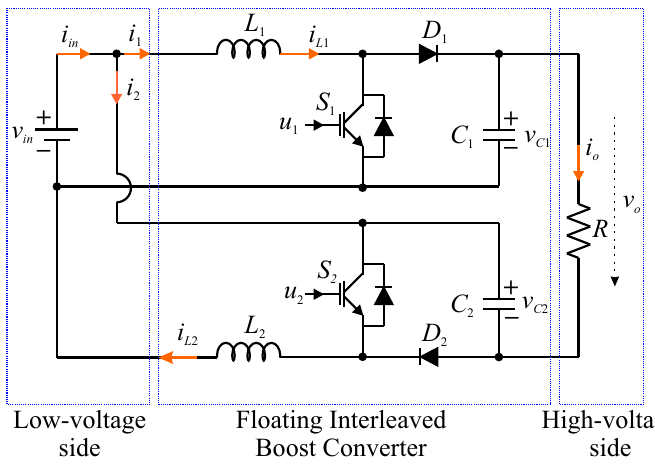
Figure 1. The schematic of the considered DC–DC boost